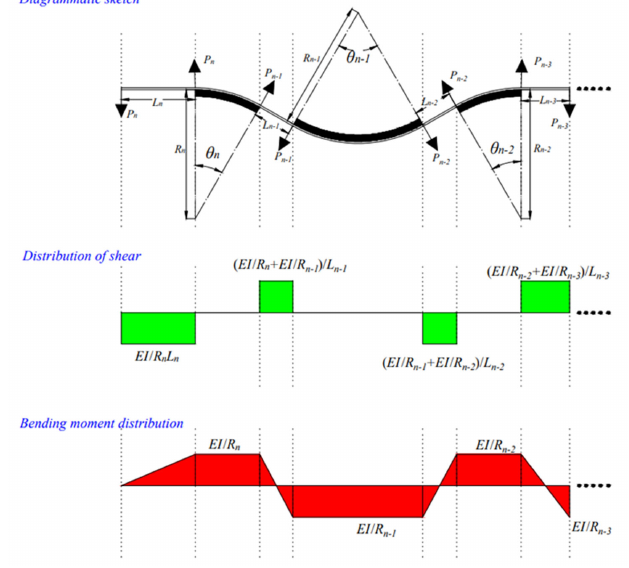
Figure 12. Sketch of the continuous bending calculation.